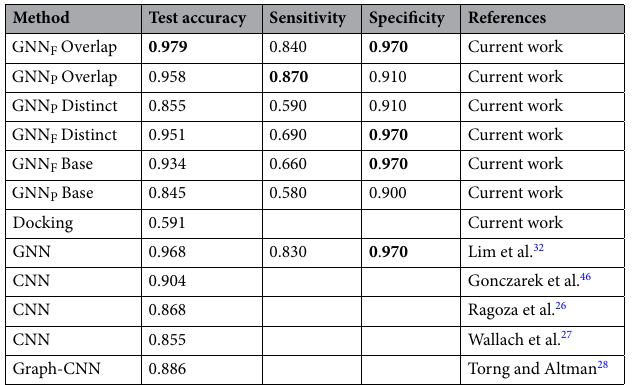
Table 6. Comparison of test dataset results for our GNN F and GNN P models on the various test sets described in the text, along with representative examples from the literature. The top scores are shown in